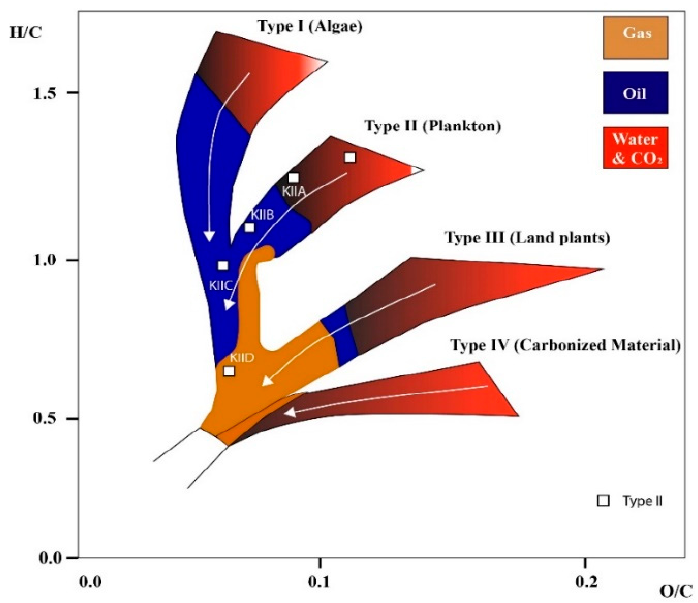
Figure 6. Kerogen structure classification indicated as increasing order of maturity (modified from [94]). White arrow shows increased level of maturity.